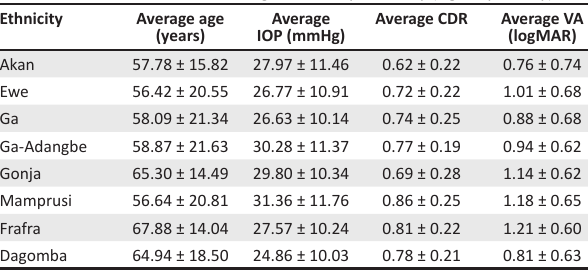
TABLE 5: Clinical characteristics of glaucoma by ethnicity (right eyes only).